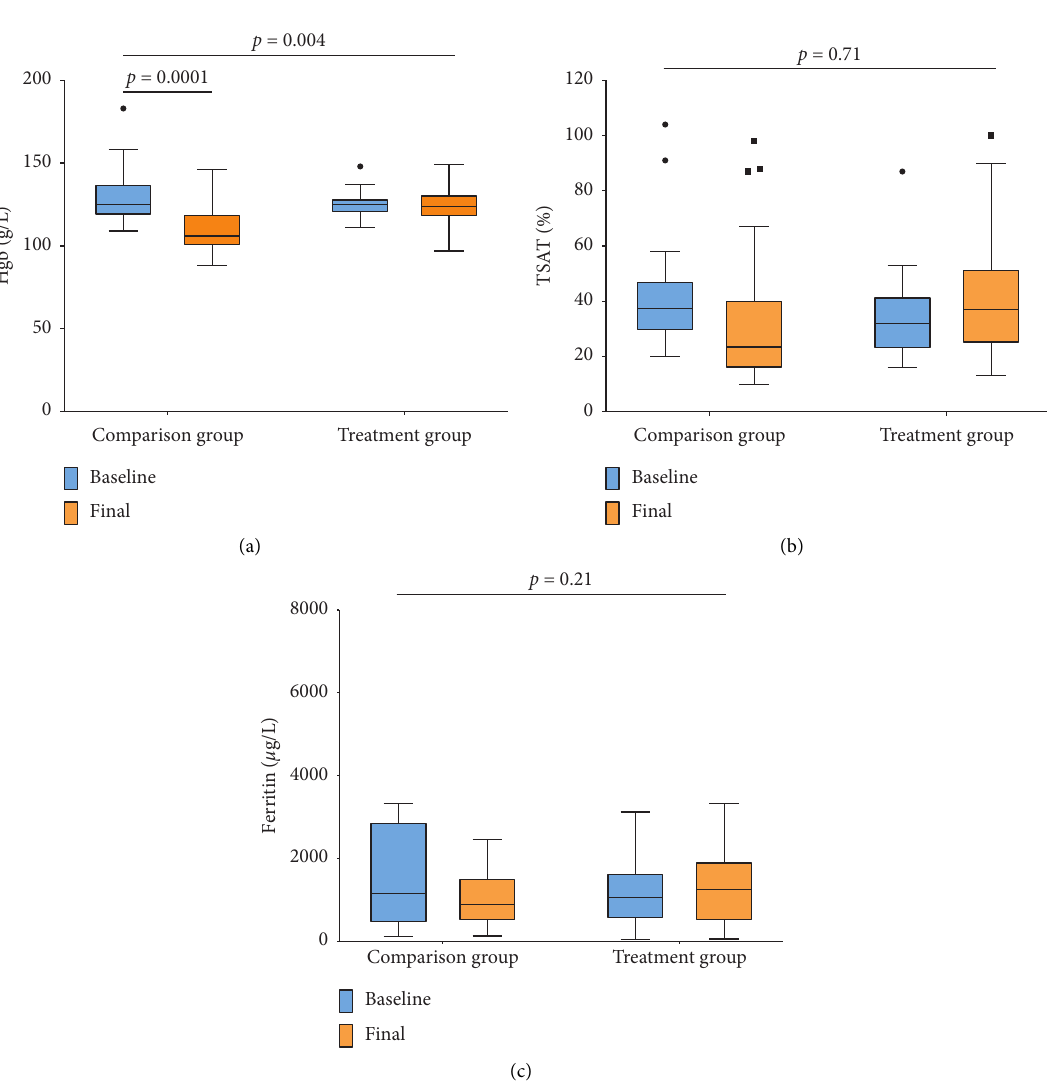
Figure 2: Hemoglobin (Hb), transferrin saturation (TSAT), and ferritin levels at baseline and at the end of the 6-week study period. The horizontal lines indicate the median value, the boxes indicate interquartile range, and the whiskers indicate the minimum-maximum value. The closed circles and squares in the first two figures represent outlying